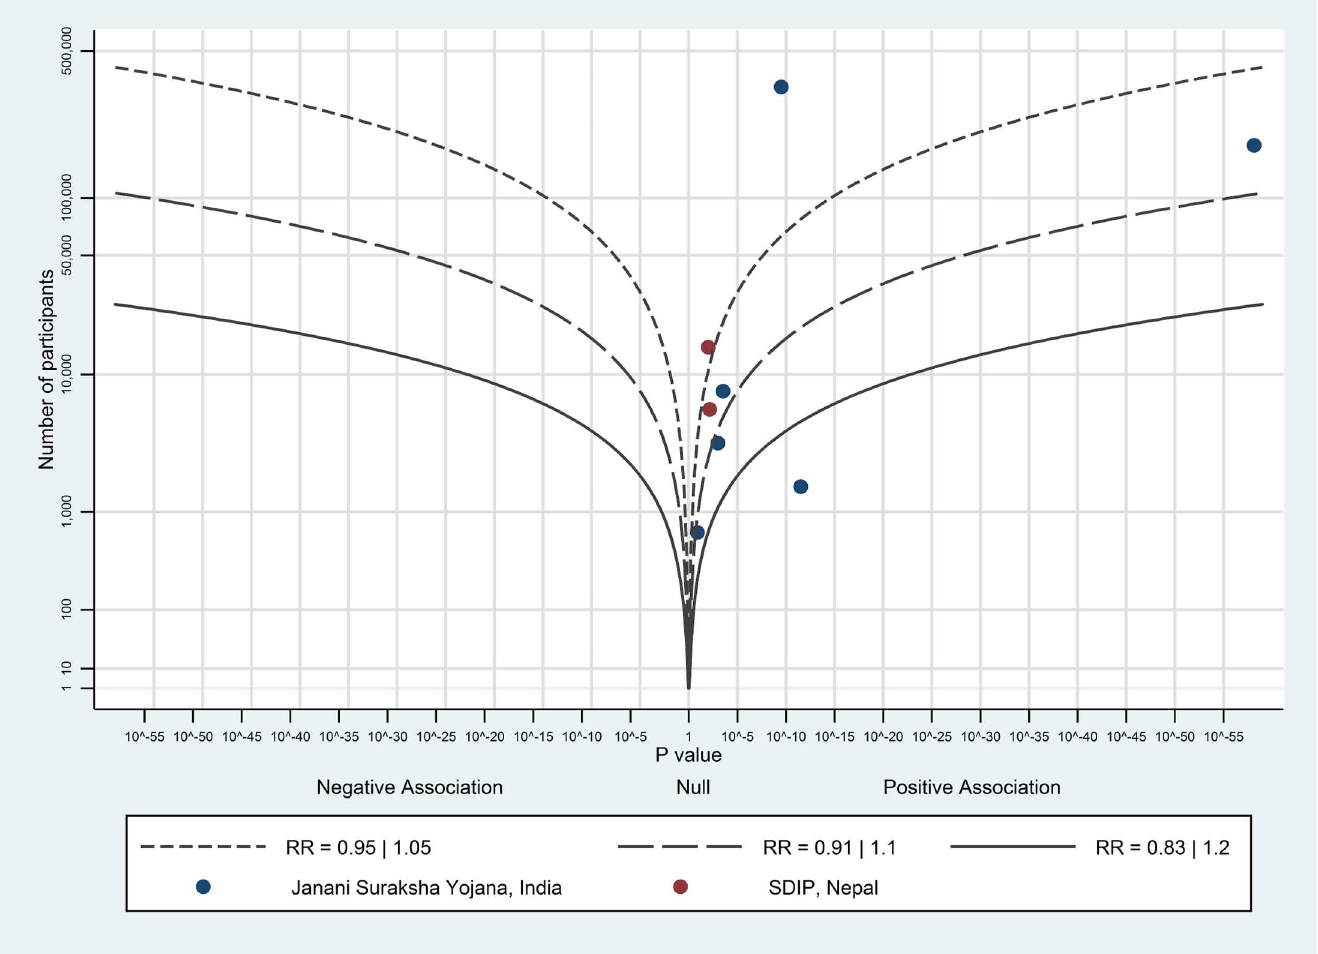
Fig 6. Albatross plot for effect of short-term cash payments on health facility births. SDIP—Safe DeliveryIncentive Programme.